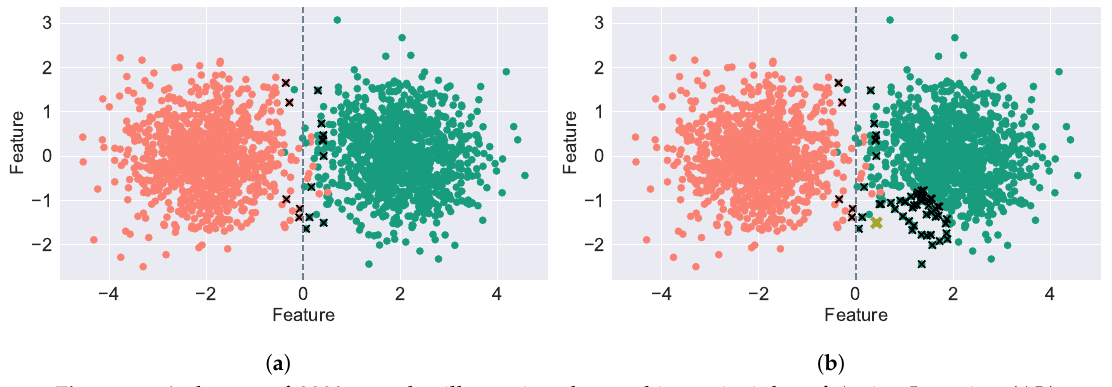
Figure 2. A dataset of 3000 samples illustrating the working principles of Active Learning (AL) and Semi-Supervised Active Learning (SSAL). The samples are illustrated with colours identifying their respective class. The samples selected by the AL for expert annotation are depicted by the × ’s. The grey vertical line denotes the decision boundary between the two classes. ( a ) Active